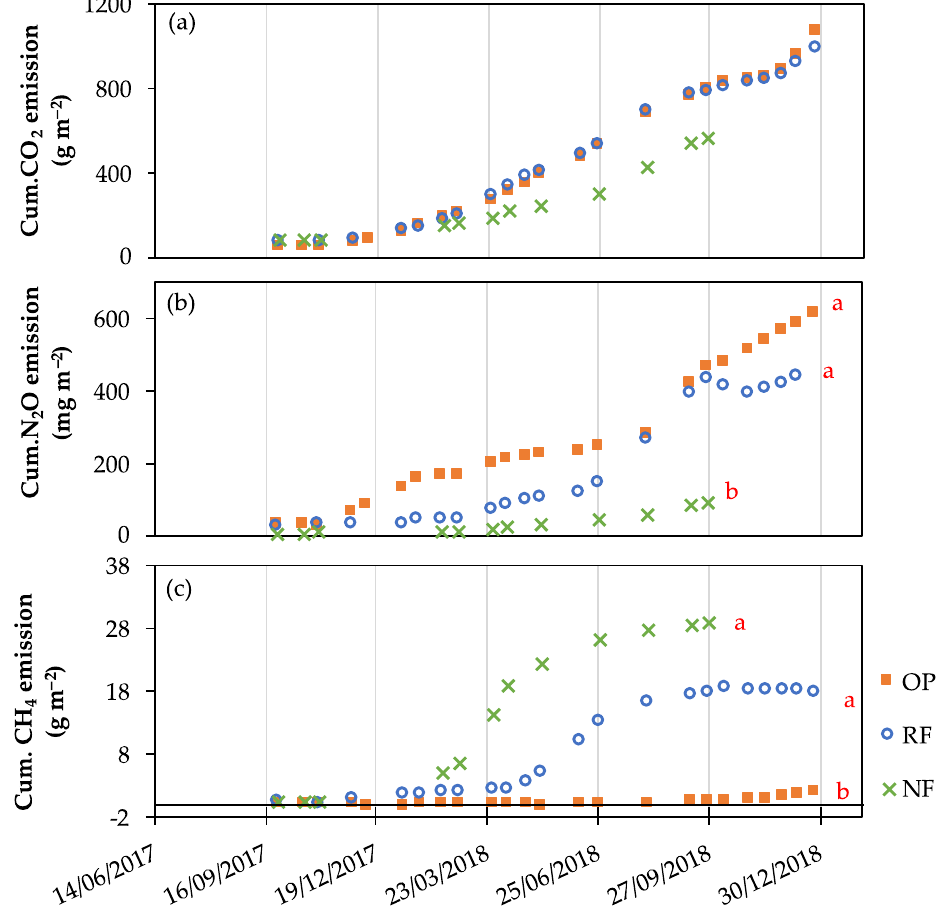
Figure 5. Cumulative emission of ( a ) CO 2, ( b ) N 2 O and ( c ) CH 4 at the oil palm plantation (OP), recovery peat swamp forest (RF) and natural peat swamp forest (NF) sites in Raja Musa, Malaysia. Note: different letters represent significantly different, α = 0.05 .